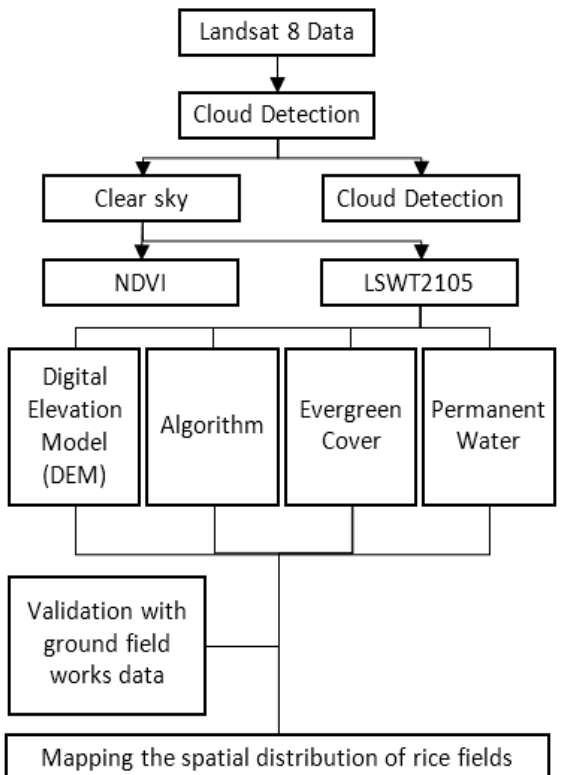
Figure 2 . The overall separation of rice paddies process